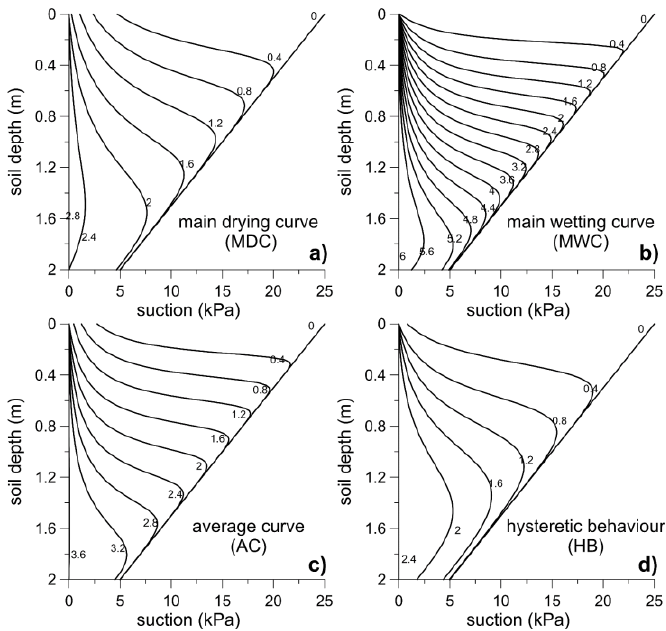
Figure 10. Calculated matric suction profiles through the soil hydrostatic initial conditions. Figures refer to different time steps (day). ( a ) MDC; ( b ) MWC; ( c ) AC; ( d ) HB.